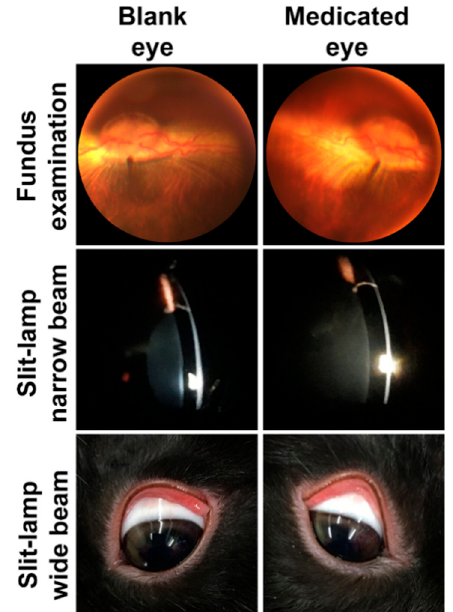
Figure 6. Photographs of fundus exam: narrow and wide beam slit-lamp biomicroscopic examination of Dutch belted rabbit eyes after 14 day of topical daily application of 100 μ L of either blank or ribavirin-loaded Carbopol 981 ME. Fundus examination showed healthy retina and optic nerve discs in both eyes. Narrow beam slit-lamp biomicroscopic examination showed clear and smooth cornea, clear aqueous humor and normal lenses for both eyes. Wide beam slit-lamp biomicroscopic examination showed healthy eye surfaces that were free from any sign of irritation, inflammation, toxicity or allergy.